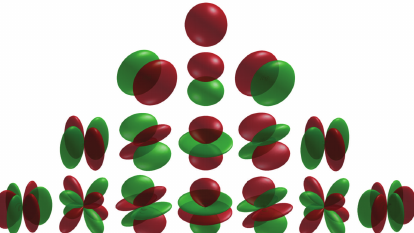
Figure 7: Visual representations of the first few spherical harmon- ics. Red portions represent regions where the function is positive, and green, negative, respectively. The right hand side of the figure shows + M numbers, and the left side, negative M numbers, so the pattern solutions shown distinguish the symmetric from the antisymmetric solutions. As usual, the L number denotes the total number of nodes, with M being the number of vertical nodes, so M = 0 denotes axisymmetric solutions, vertically downward from the top. The L = M mode denotes sectoral nodes, having no vertical nodes, as a vertically sliced orange would. These sectoral nodes are shown diagonally downward on the right hand side, and the antisymmetric form M = − L diagonally downward on the left. The original solar sector pattern had an L = 2, M = ± 2 form, shown in the third row downward on the right or left. The very top spherically symmetric node is the monopole term, positive everywhere, or alternatively negative everywhere, and the second one vertically downward is the quadrupole term ( l = 2, m = 0), negative in the equatorial plane and positive at both poles, or vice- versa. The g coe ffi cient can multiply the form to be negative of the actual spherical